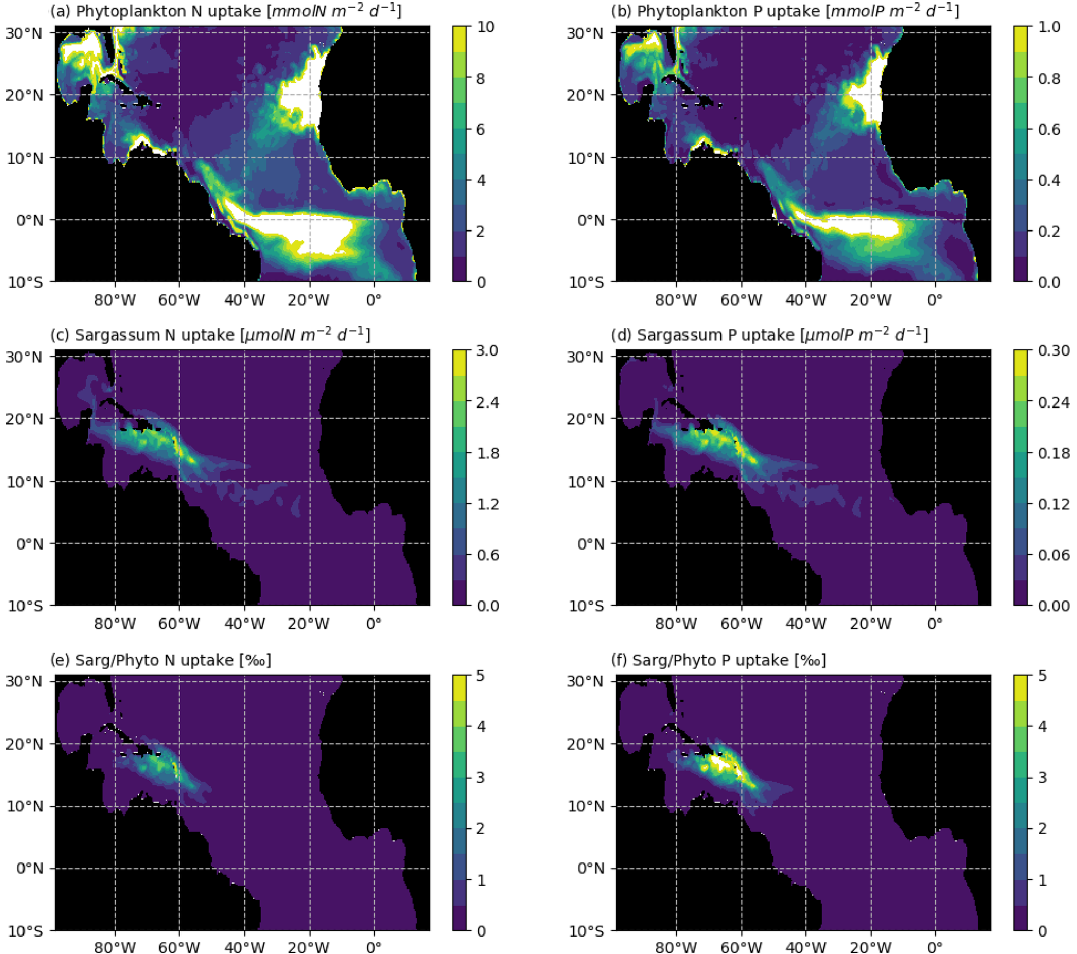
Figure 11. Average N and P uptake by phytoplankton (in mmolm − 2 d − 1 ; a and b , respectively) and by Sargassum (in µmolm − 2 d − 1 ; c and d , respectively). The N and P uptake by phytoplankton were obtained from the biogeochemical simulation, assuming a constant stoichiometry. The uptake rates were integrated over the model mixed-layer depth for each month of 2017 and averaged over the year. The bottom row shows the Sargassum vs. phytoplankton mean consumption ratio of (e) N and (f) P (in ‰) for the year